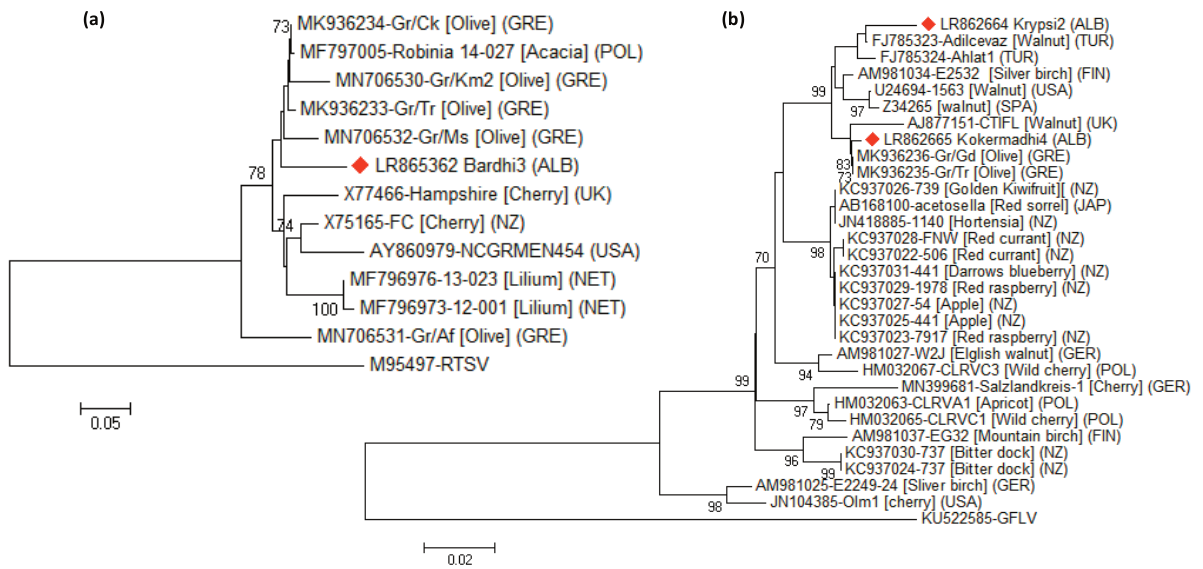
Figure 1. Phylogenetic trees based on nucleotide sequences of different partial genes\domains of SLRSV (a), CLRV (b), OLV-1 (c), CMV (d) and OLYaV (e). Alignments were obtained using Clustal X 1.8, and analyzed by the Neighbor-Joining method with 1000 bootstrap rep- licates. The percentage of replicate trees (when >70%) in which the virus isolates clustered together is shown next to each branch. GenBank accession number, name, isolation sources and countries of origin of each corresponding virus isolate used in the analysis are reported in the phylogenetic tree. Rice tungro spherical virus (RTSV) of the genus Waikavirus , Grapevine fanleaf virus (GFLV) of the genus Nepovirus , Olive mild mosaic virus (OMMV) of the genus Alphanecrovirus , Fig mosaic virus (FMV) of the genus Emaravirus and Daucus carota HSP70 gene, were used as outgroup species. The abbreviations used for countries of origin of the isolates are: Albania (ALB); Australia (AUS); Chile (CHI); Croatia (CROA); Egypt (EGY); Finland (FIN); France (FRA); Germany (GER); Greece (GRE); India (IND); Israel (ISR); Ita- ly (ITA); Japan (JAP); Malaysia (MAL); Netherlands (NET); New Zealand (NZ); Palestine (PAL); Poland (POL), Portugal (PORT); South Korea (S-KOR); Spain (SPA); Tunisia (TUN); Turkey (TK); Uganda (UGA); United Kingdom (UK); and United States of America (USA). Albanian virus isolates are indicated in